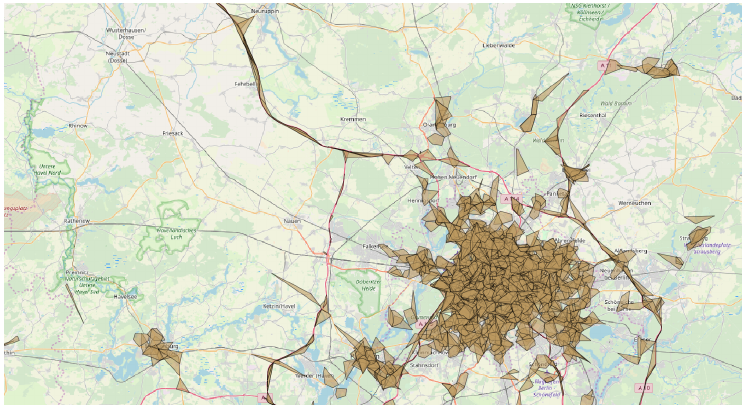
Figure 17. Distribution of microcells in the Berlin